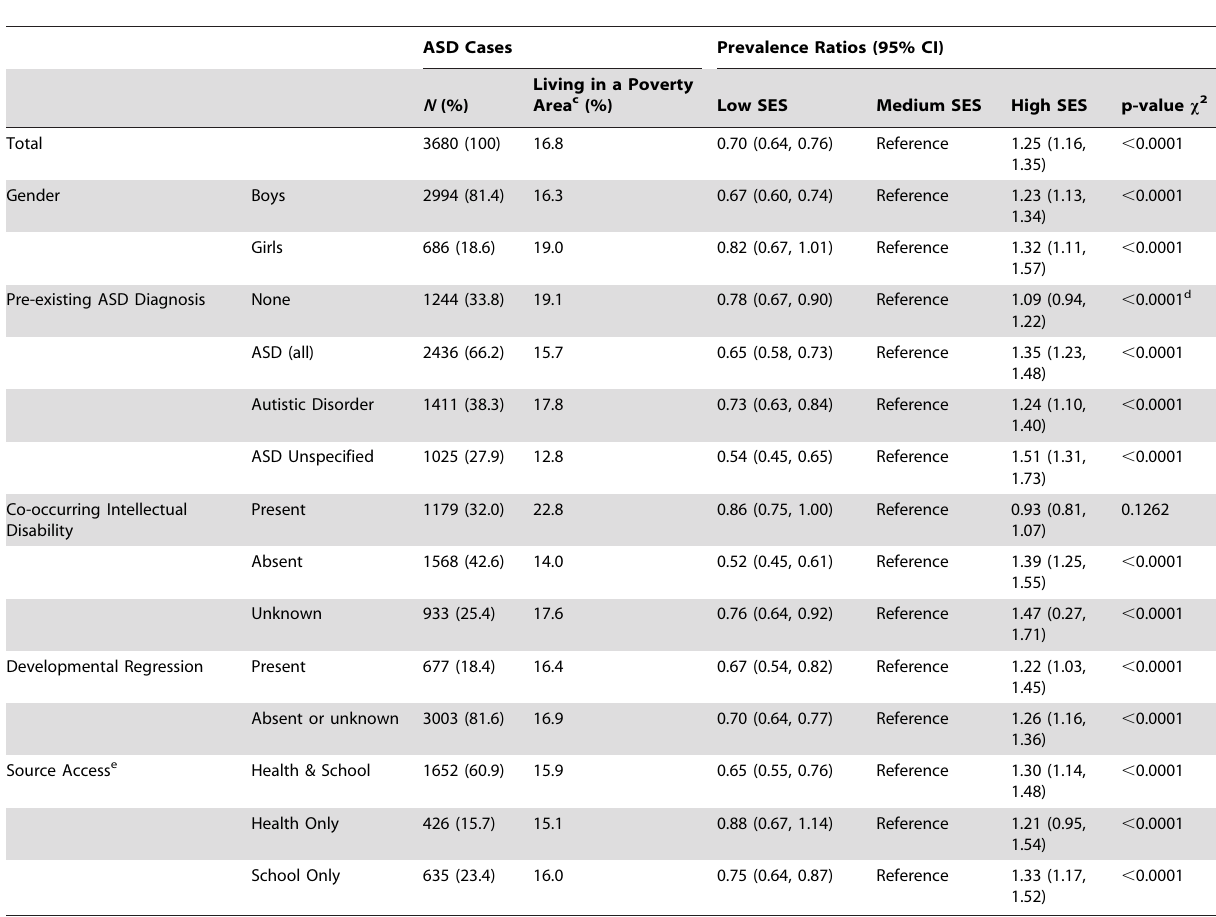
Table 4. Stratified Results: ASD and SES a Prevalence Ratios (95% CI b ), Stratified by Gender, Pre-existing Diagnosis, Co-occurring Intellectual Disability, Developmental Regression, and Data